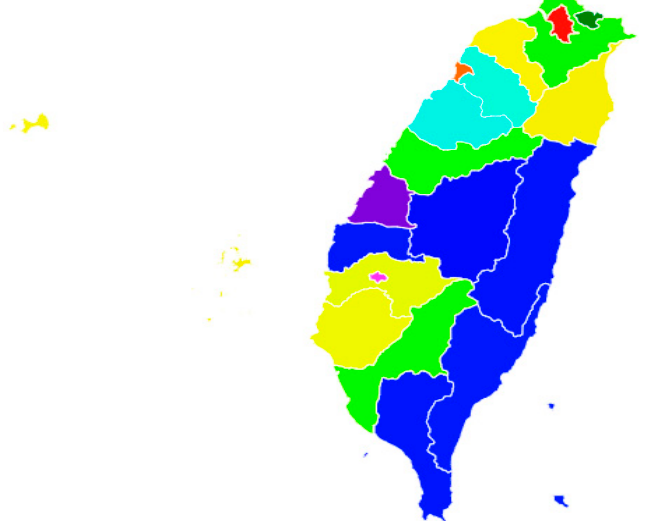
Figure 3. Map of active aging and age friendly city clusters in Taiwan. Note: The city clusters color (city numbers): Developed and Infrastructural: red (1); Developed and Tranquil: orange (1); Content and Tranquil: yellow (5); Content and Infrastructural: light green (3); Participatory and Infrastructural; dark green (1); Participatory and Tranquil: light blue (6); Content and Insecure: dark purple (1); Participatory and Insecure: blue (5); Pioneer and Insecure: pink purple (1).